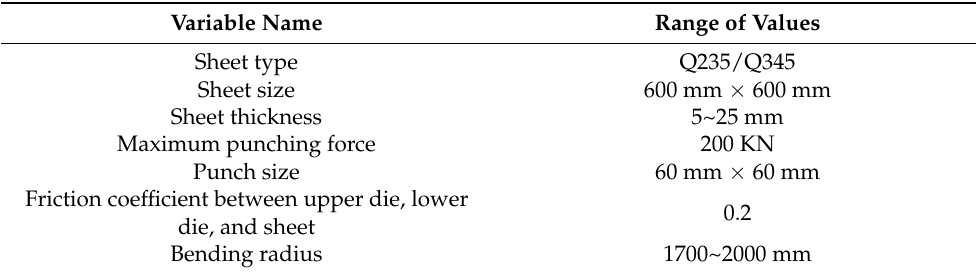
Table 3. Parameters in finite element simulation.